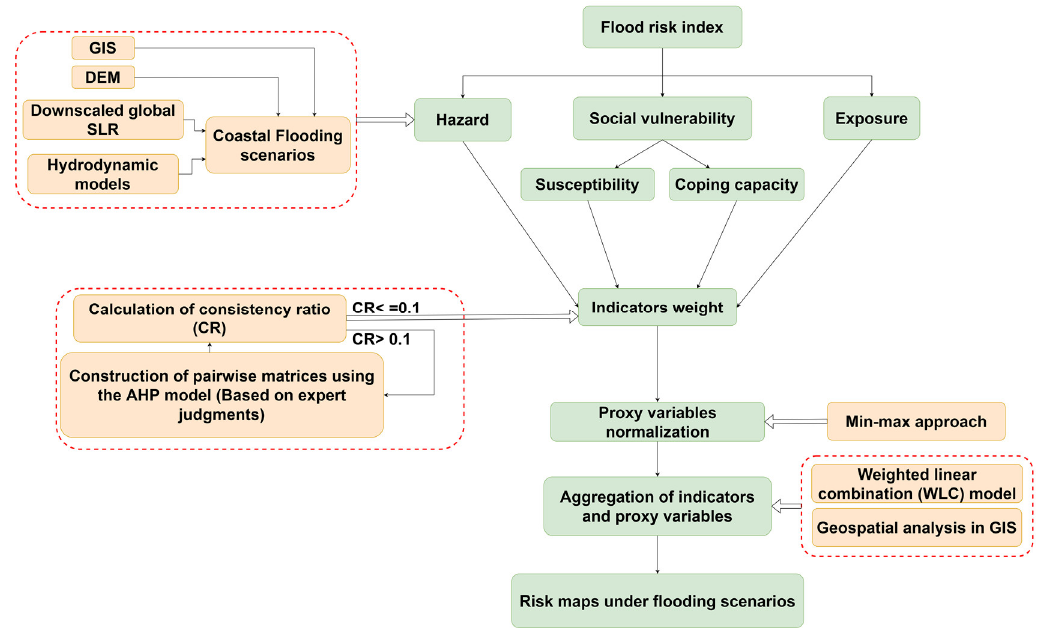
Figure 2. The adopted methodology of the study.